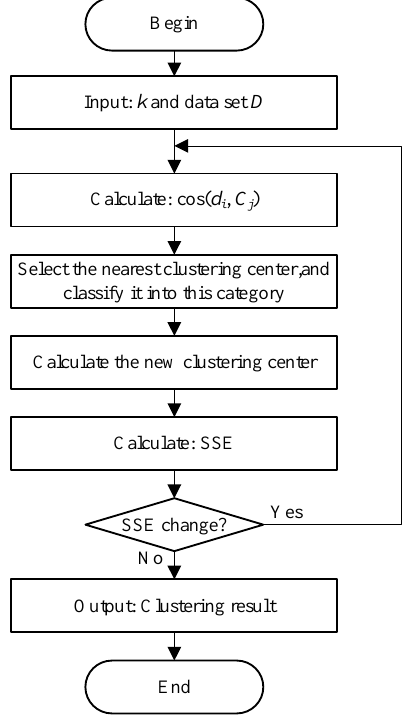
Figure 3. Flow chart of cosine K-means algorithm.